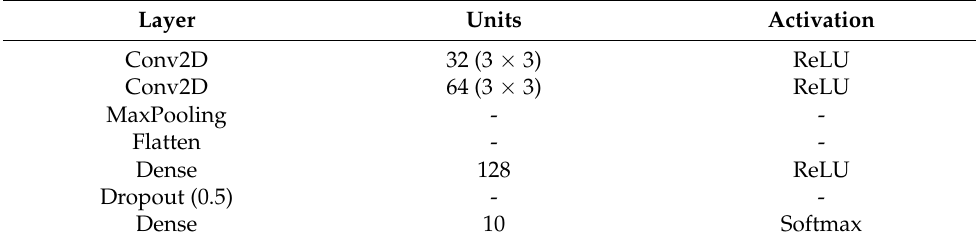
Table 7. Model architecture for the MNIST dataset (CNN